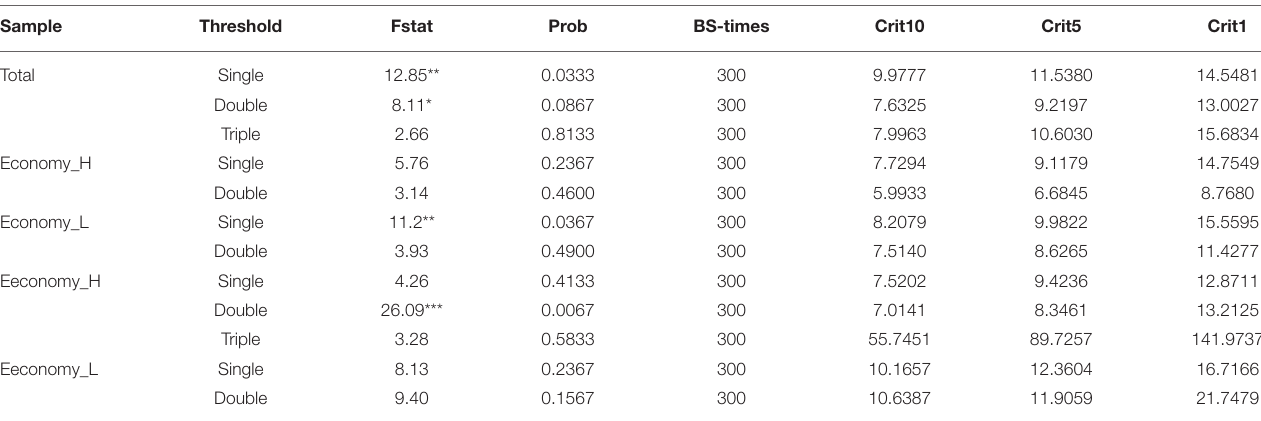
TABLE 7 | Robustness check_ test for threshold (change X variable).